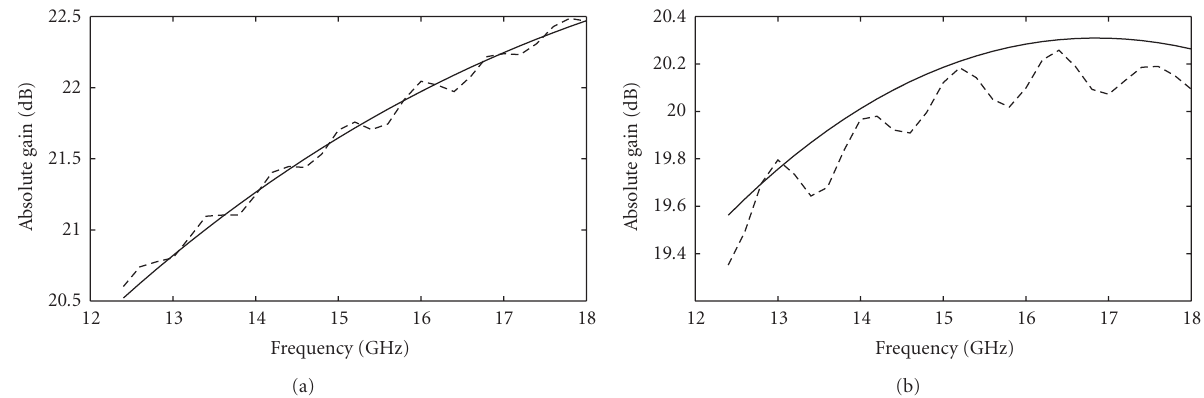
Figure 2: Gain pattern for a Ku -band conical horn. (a) L = 17.78 cm (optimum axial length), (b) L = 12.68 cm (less than minimum axial length required for normal gain pattern). The solid line is obtained by using approximate gain formula [3]. The dashed line is simulated by using CST Microwave Studio.